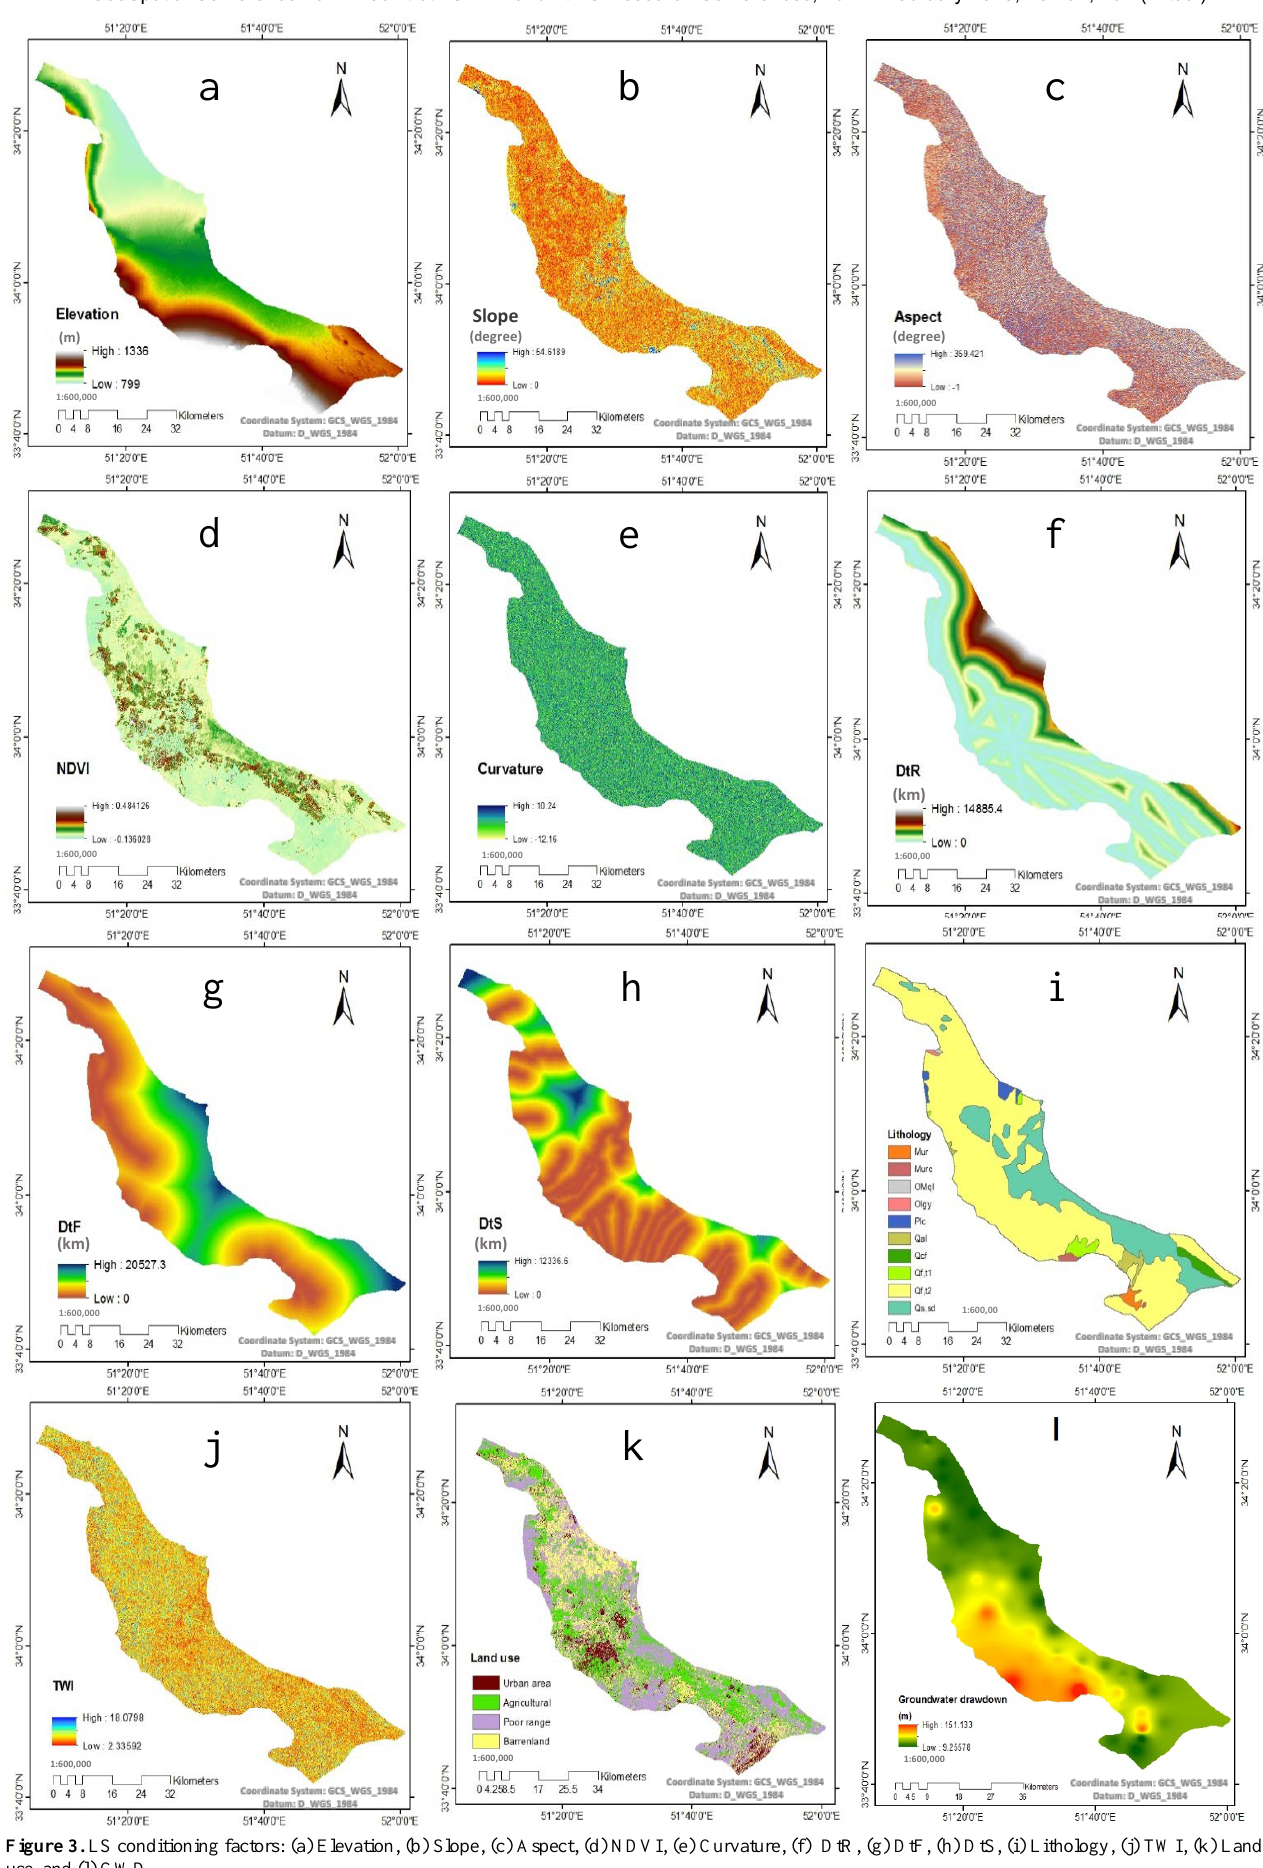
Figure 3. LS conditioning factors: (a) Elevation, (b) Slope, (c) Aspect, (d) NDVI, (e) Curvature, (f) DtR, (g) DtF, (h) DtS, (i) Lithology, (j) TWI, (k) Land use, and (l)